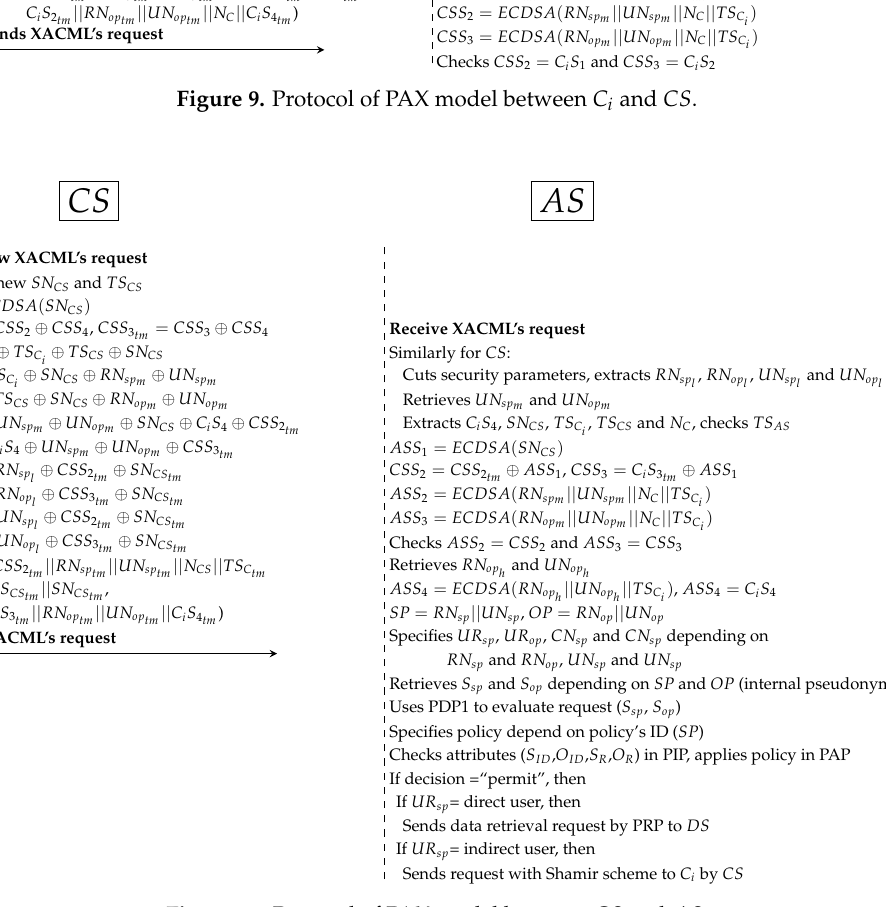
Figure 10. Protocol of PAX model between CS and AS